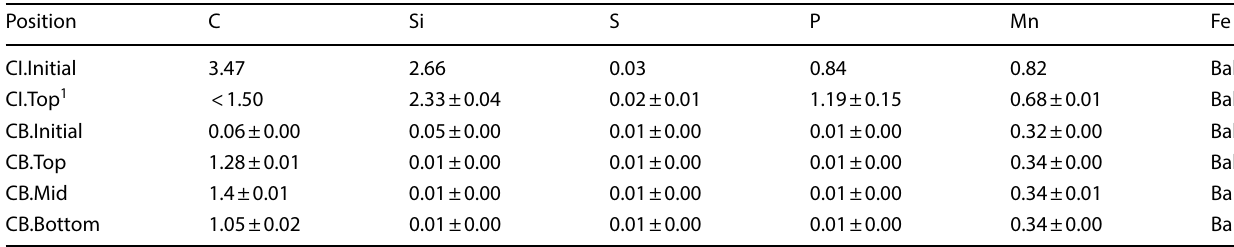
was measured with optical emission spectrometry. 1 Measured with calibrated OES grey cast iron